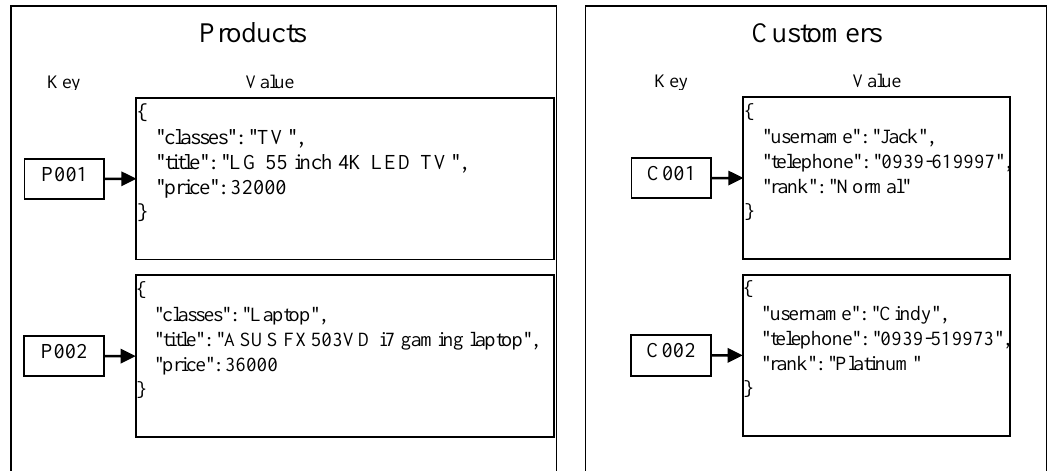
Figure 3. An example of two namespaces in a key value store database.